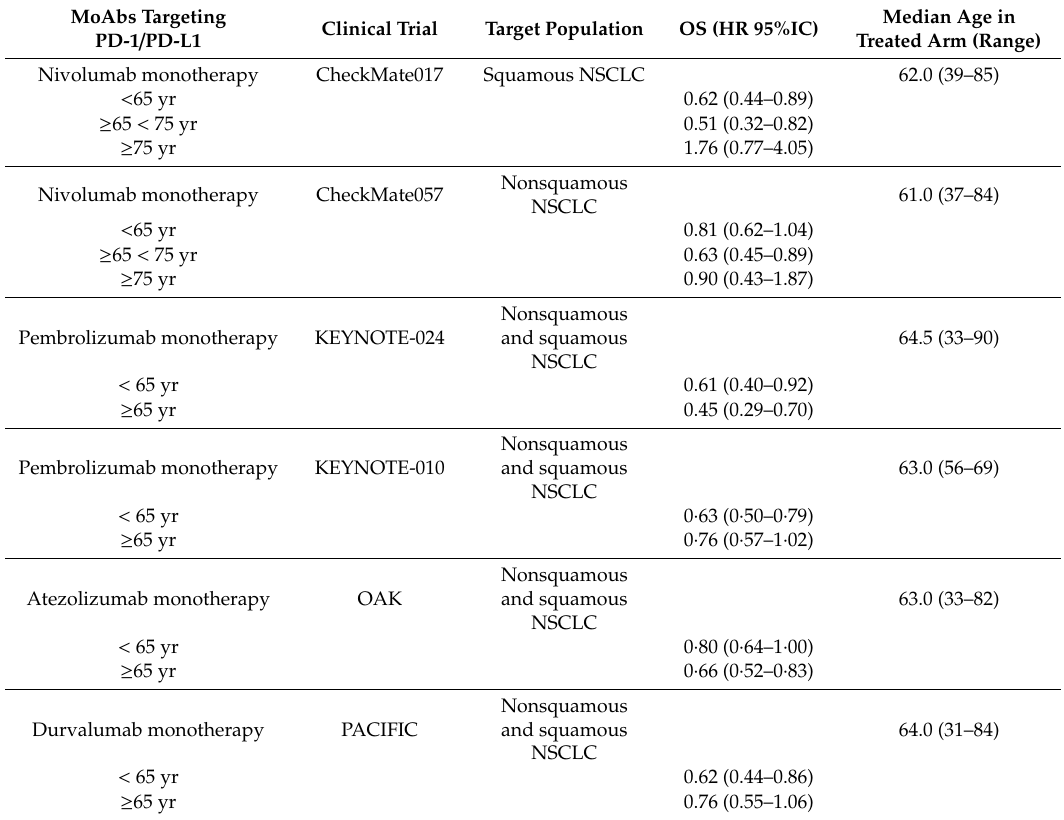
Table 1. Results of Immune checkpoint inhibitors in clinical trials adjusted by